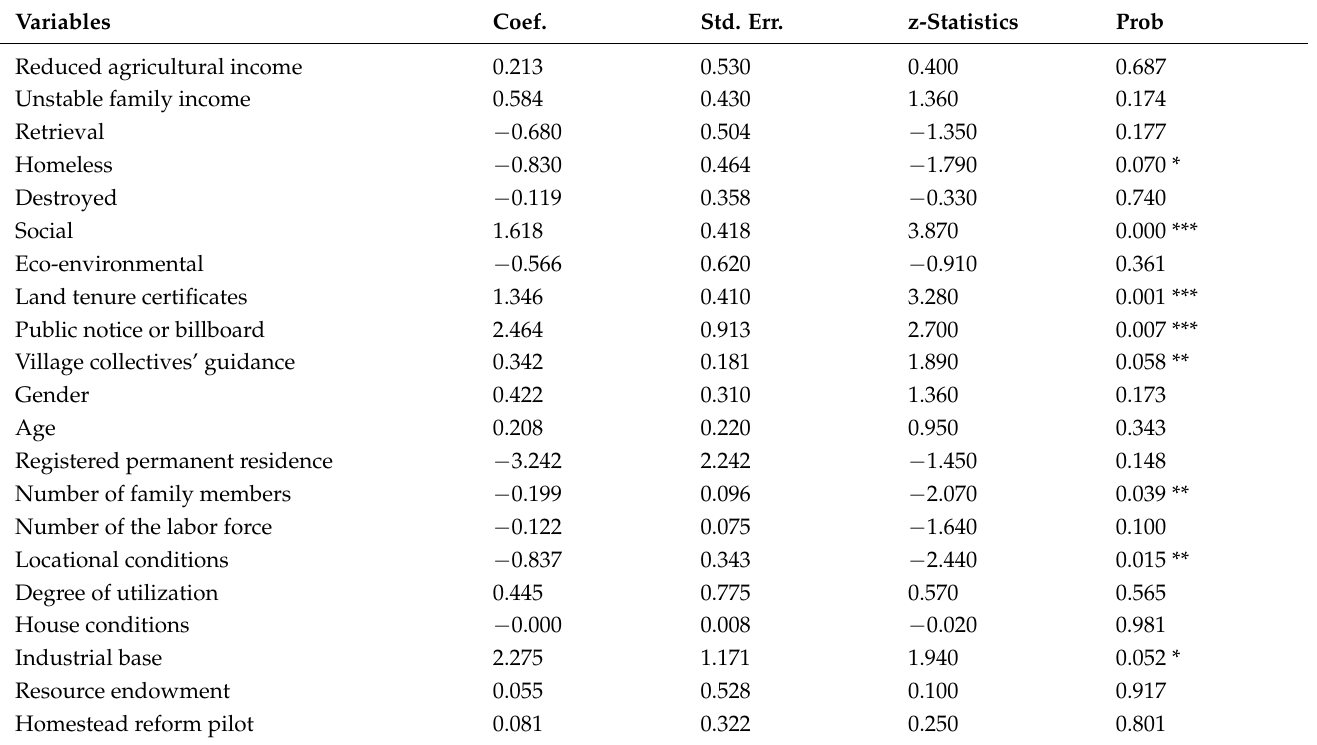
Table 6. Regression results of selection bias